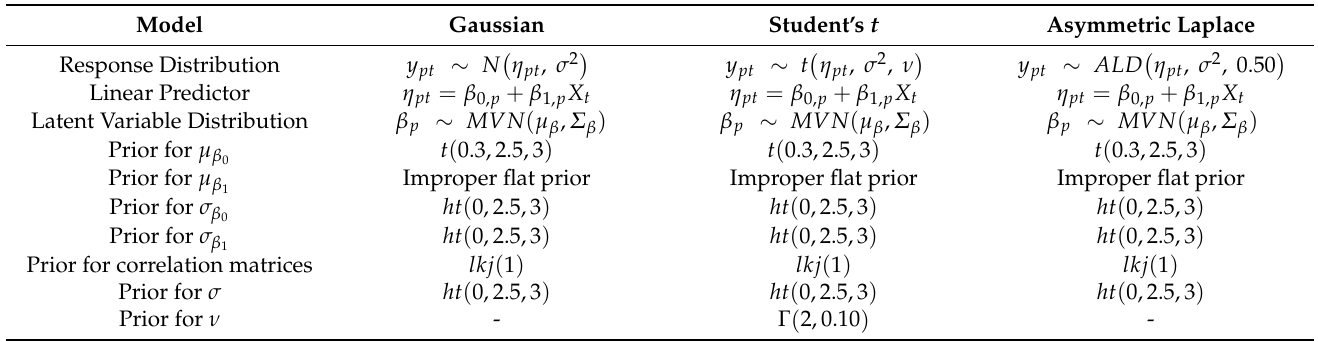
Table 1. Linear Latent Growth Model Definitions and Used Prior